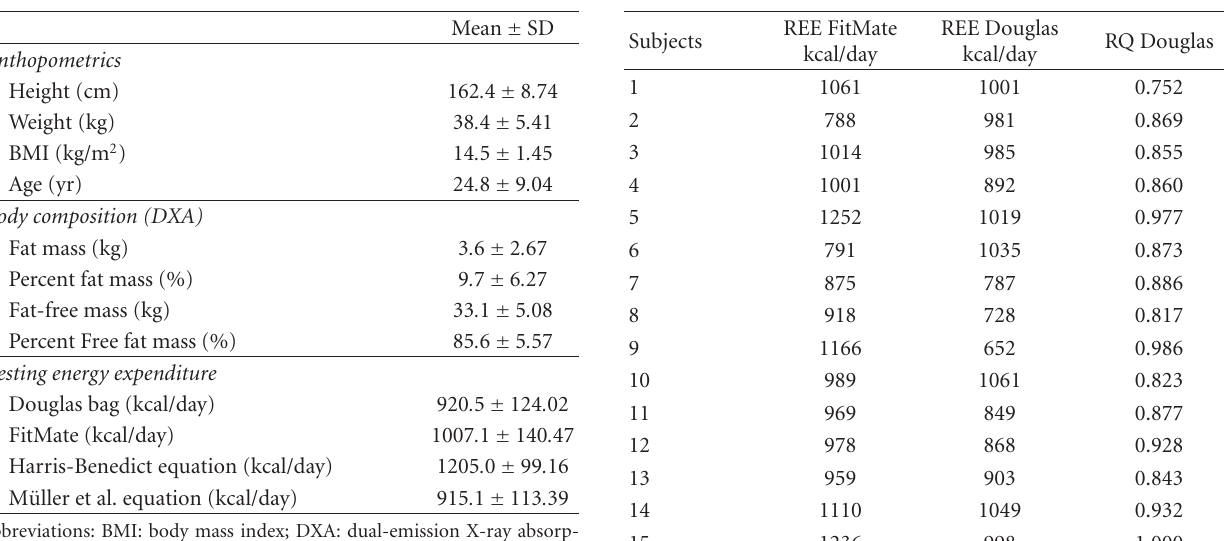
Table 1: Data of the 15 AN patients (14 females and one male) participating in the study.